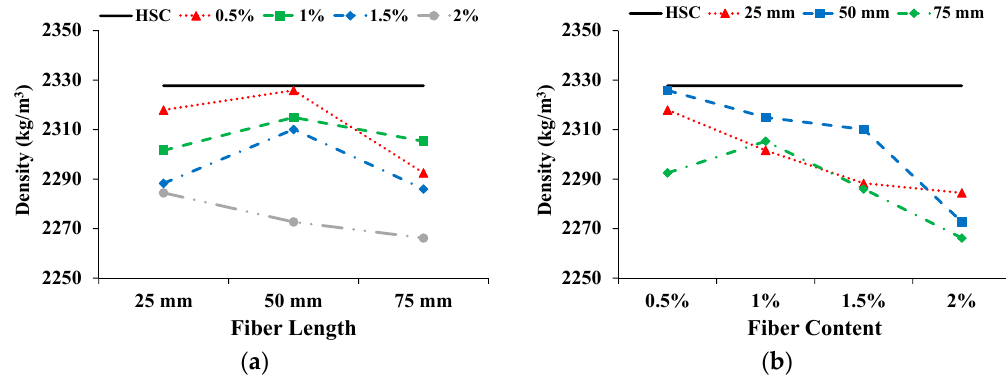
Figure 3. Influence on density: (a) Fiber length; (b) Fiber content.